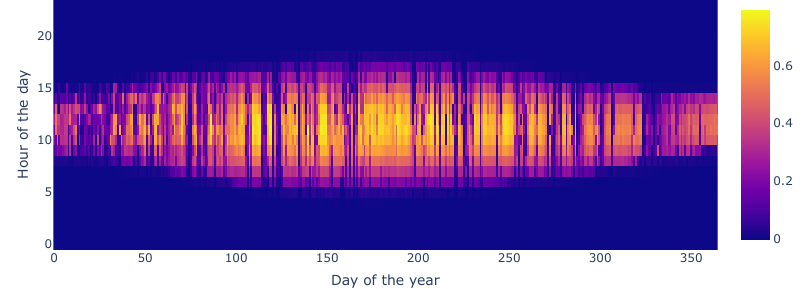
Figure 6. Daily differences among PV power profiles.